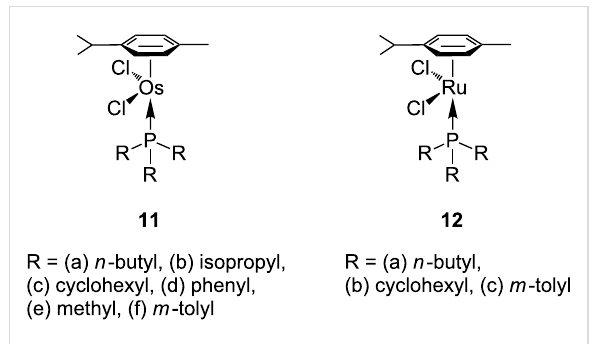
Figure 4: Ruthenium and osmium complexes with p -cymene and phosphane ligands for PROMP.